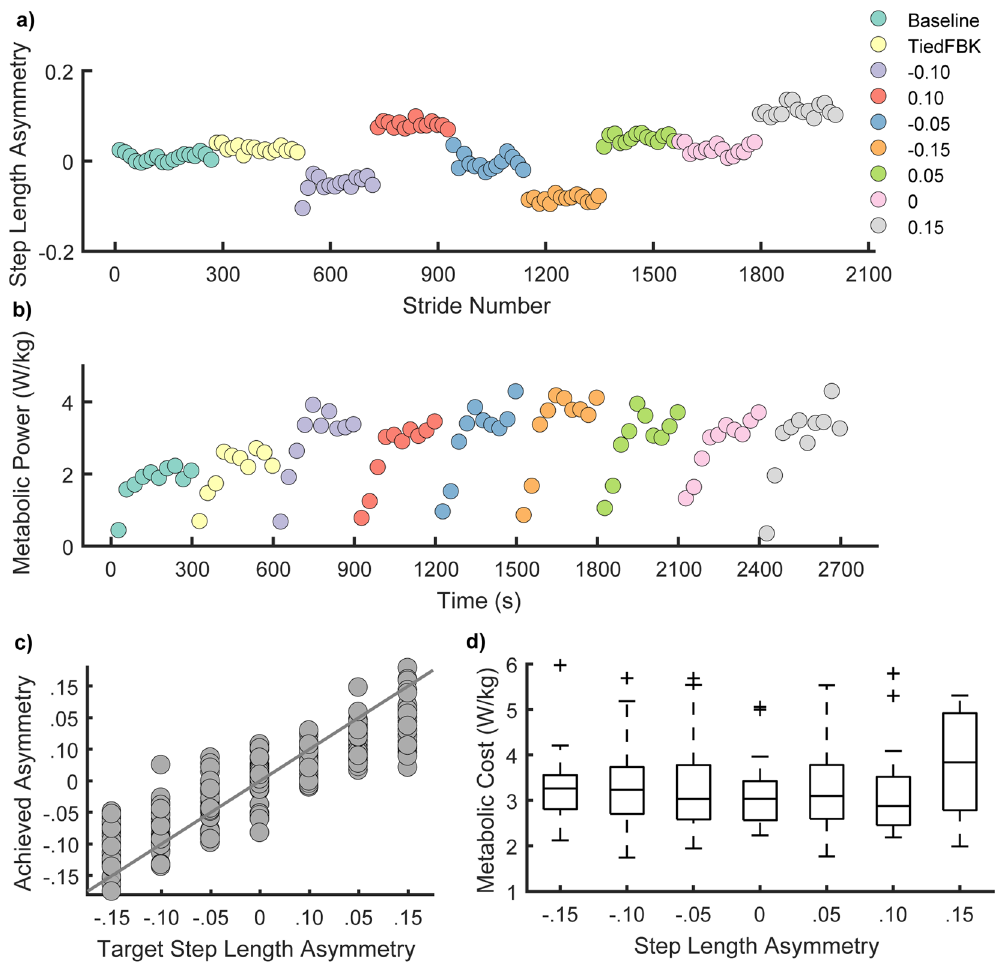
Figure 2. Metabolic cost and step length asymmetry. ( a ) Raw data for a representative participant for step length asymmetry. Each data point represents the average asymmetry during a 15-stride interval. The target asymmetries for this participant were presented in the following order: − 0.10, 0.10, − 0.05, − 0.15, 0.05, 0 and 0.15. ( b ) Raw metabolic cost data for the representative participant in ( a ). Each data point corresponds to the average metabolic power for a 30s interval. ( c ) Target step length asymmetry vs. achieved step length asymmetry for all participants (N = 30). Accurate performance would follow the gray the line. Participants typically undershot the targets for the end ranges ( + / − 0.15) due to the difficulty of the task. ( d ) Distributions of metabolic cost associated with each level of achieved